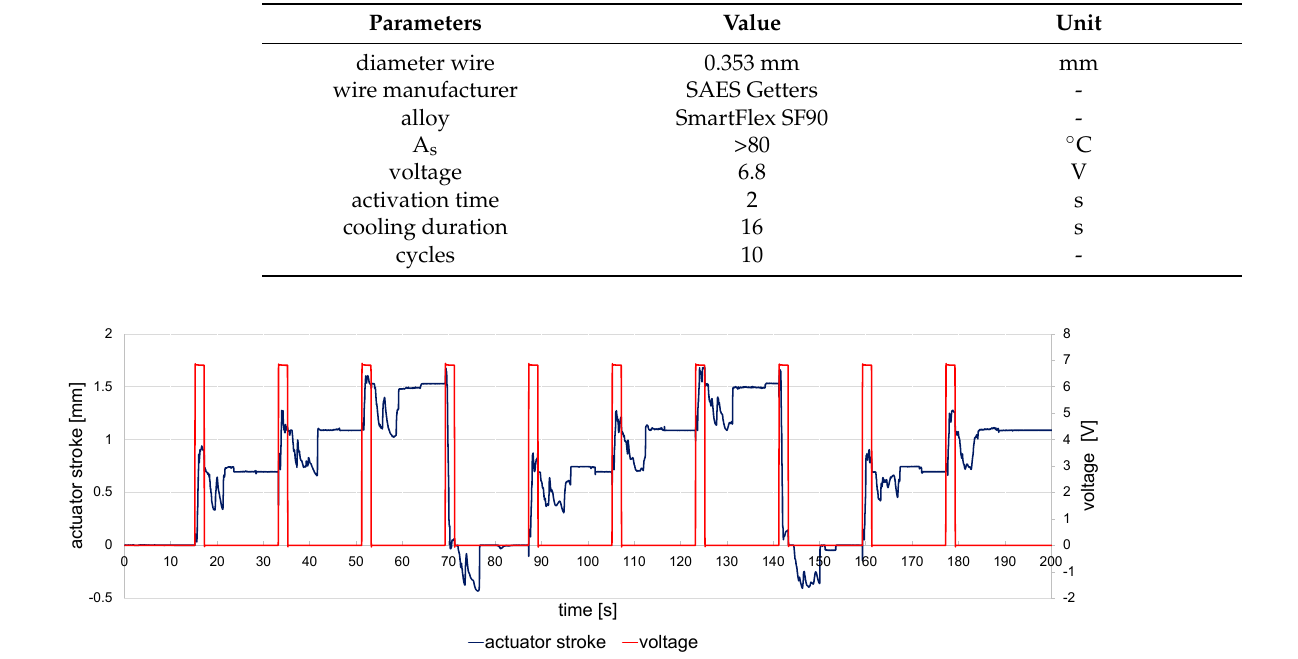
Figure 14. Applied electrical voltage and resulting generated stroke of the prototype actuator plotted over time for 10 cycles.